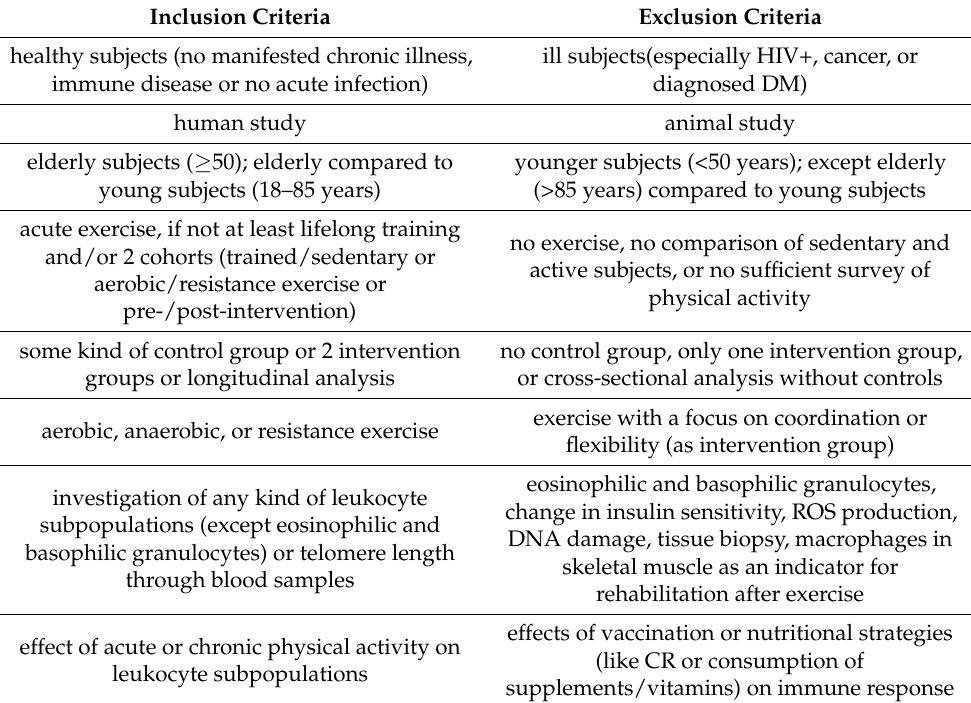
Table 3. Eligibility criteria for inclusion and exclusion of